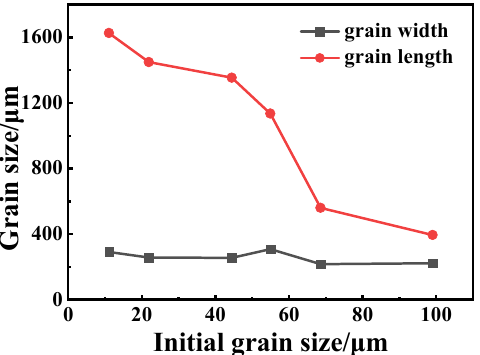
Figure 11. Trend of grain length and grain width as a function of initial grain size after directional annealing at 3.3 μ